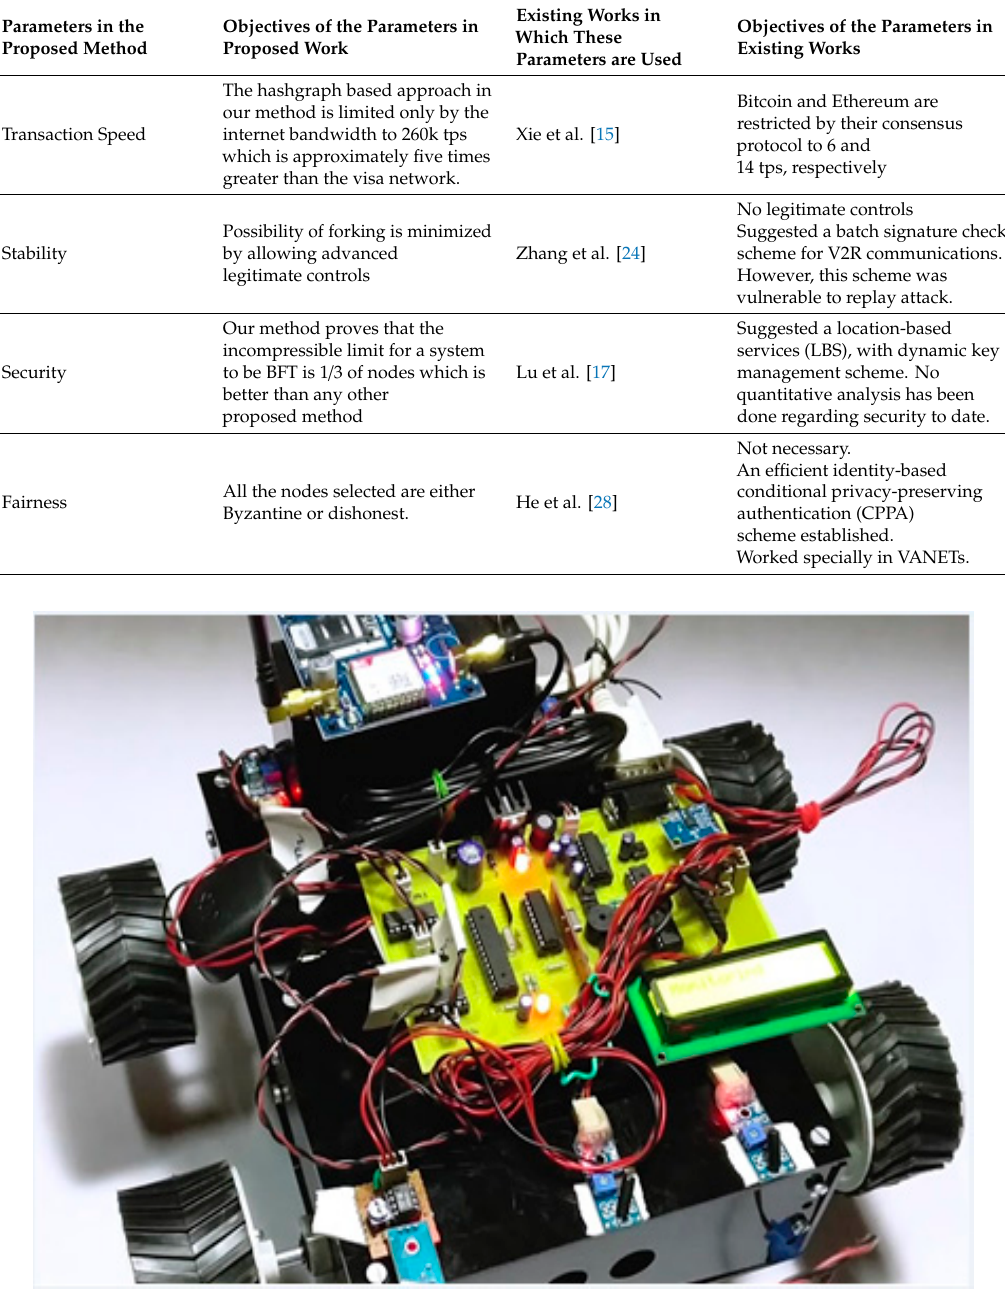
Figure 9. Fabricated hardware for a vehicle for integration with the hashgraph.